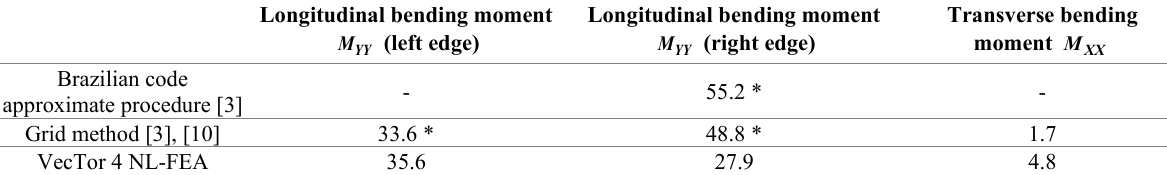
Table 2 S imple planar shear wall maximum bending moments (kN∙m/m).